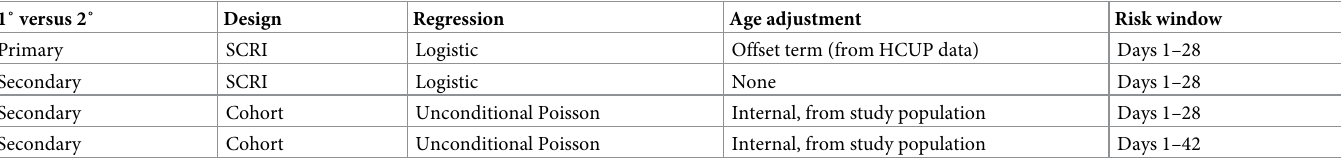
Table 1. Statistical analysis methods